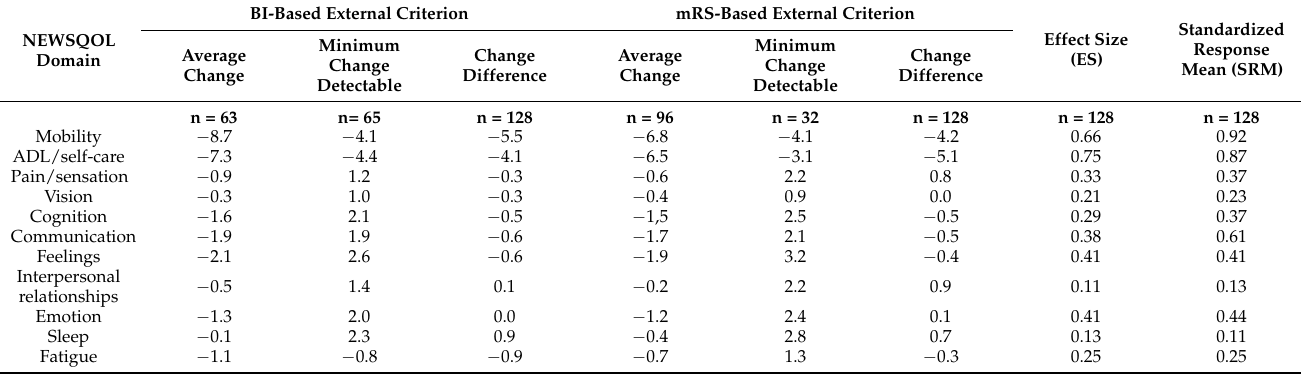
Table 5. Responsiveness statistics for the Spanish version of NEWSQOL and clinical measures by external